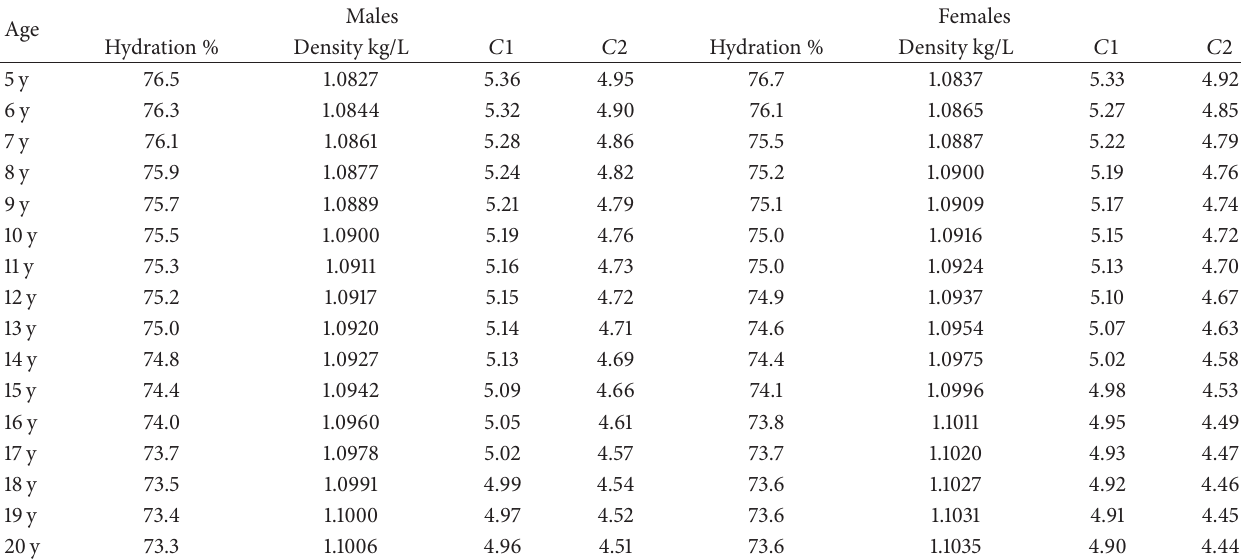
Table 2: Median values for hydration, density, and constants ( 𝐶1 and 𝐶2 ) for the paediatric version of Siri’s (11) equation, obtained by using the LMS (lambda-mu-sigma) method ∗